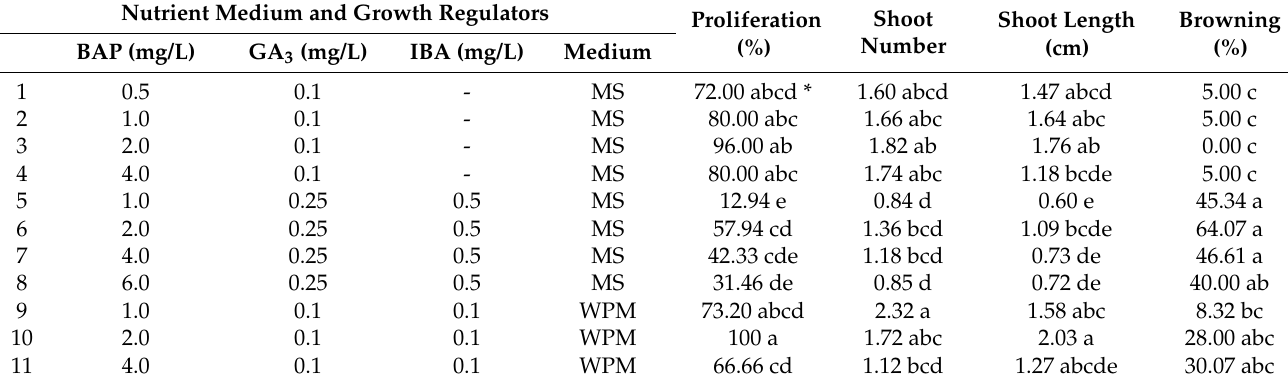
Table 3. Effect of growth hormones on explant response and survival, as determined through the percentages of proliferation and browning, as well as the shoot number and shoot length of YV2.